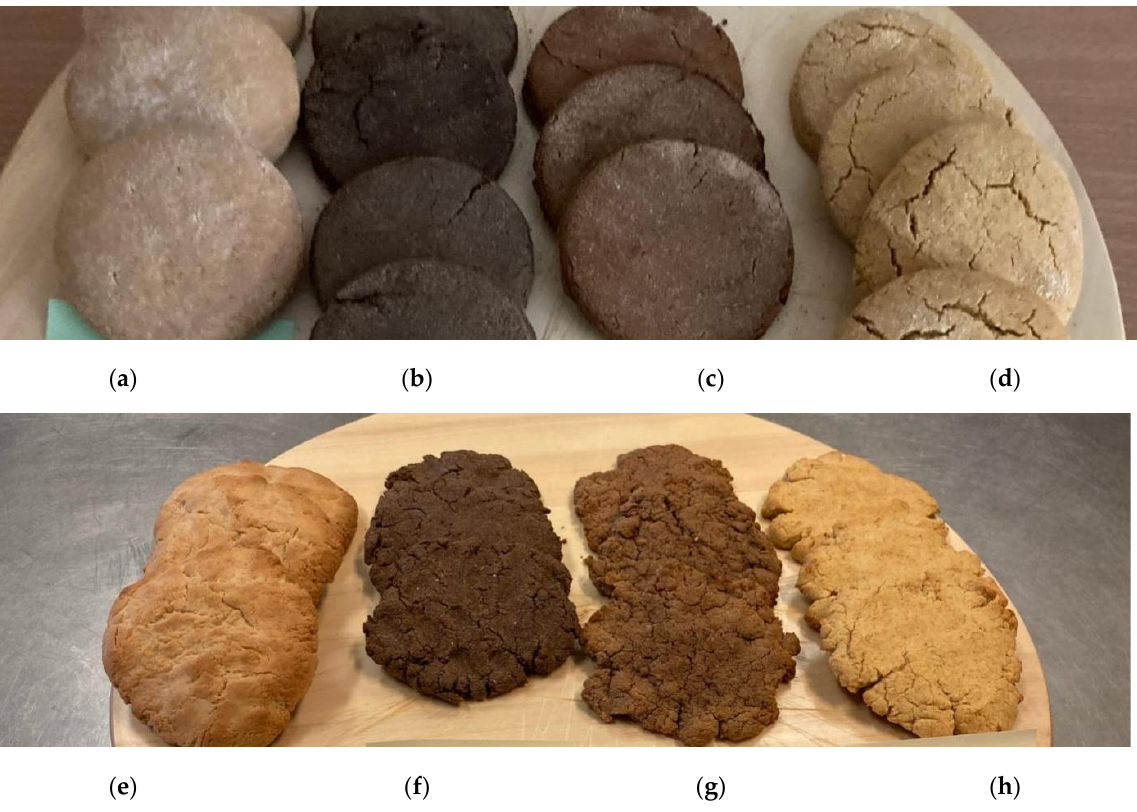
Figure 4. The gingerbread samples prepared using commercial glucose syrup and wheat ( a ), flaxseed ( b ), buckwheat ( c ), and corn ( d ) flour. The gingerbread samples prepared using the experimental glucose syrup and wheat ( e ), flaxseed ( f ), buckwheat ( g ), and corn ( h ) flour.